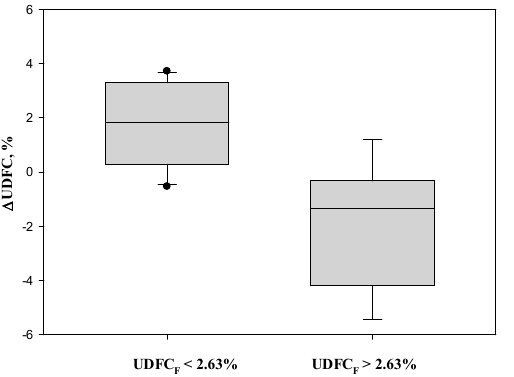
Figure 4. Alteration in the percentage of undeformable cells ( ∆ UDFC, %) in the RBC population following mechanical stress (applied to cells by rolling with steel beads). p = 0.0007.